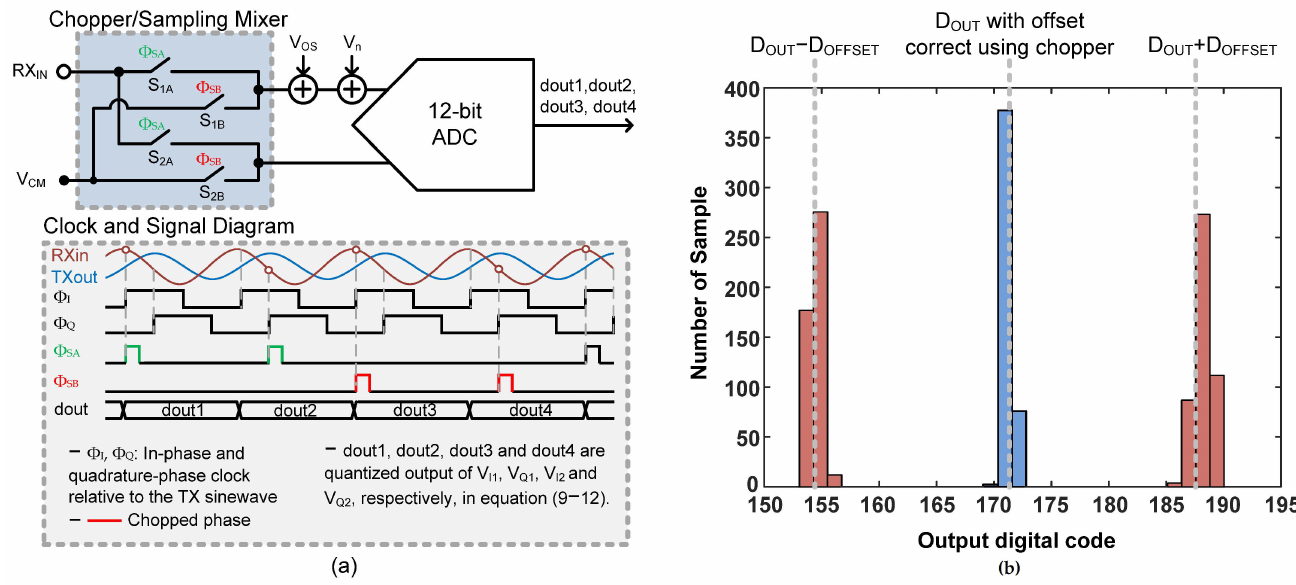
Figure 4. ( a ) The block diagram of a chopped sampling mixer along with key waveforms. ( b ) The simulation result of offset cancellation using a chopping